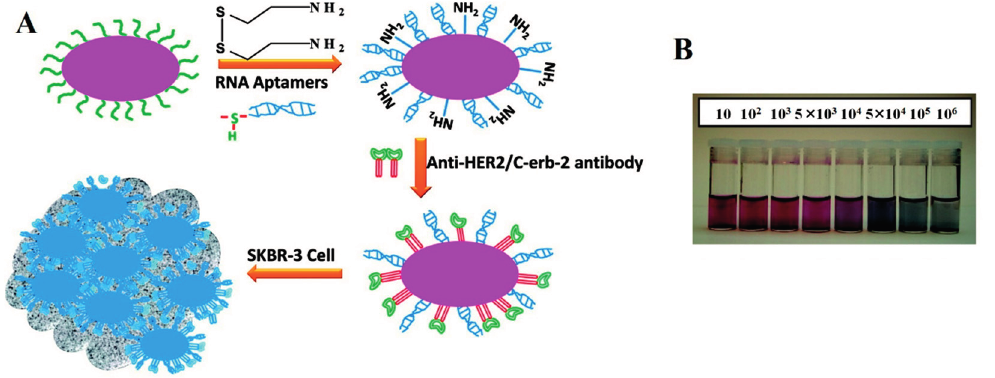
Figure 2. ( A ) Schematics of the conjugation of an aptamer and monoclonal anti-HER2 antibody with oval-shaped AuNPs and their accumulation on a cell surface; ( B ) The effect of SK-BR-3 cell concentration on the colorimetric change (pink to bluish) of oval-shaped AuNPs. The image was adopted from